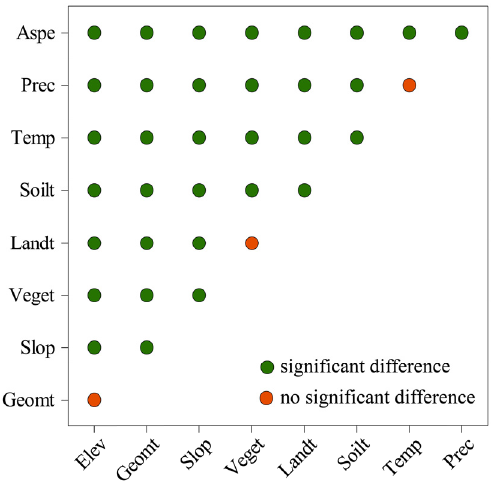
Figure 13. Statistical significance of driving factors.